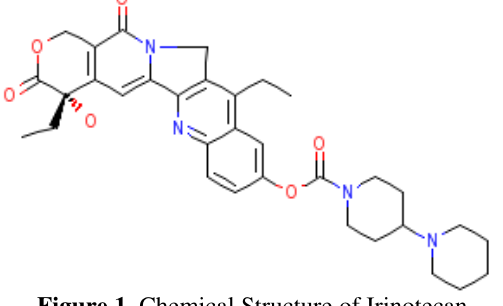
Figure 1 . Chemical Structure of